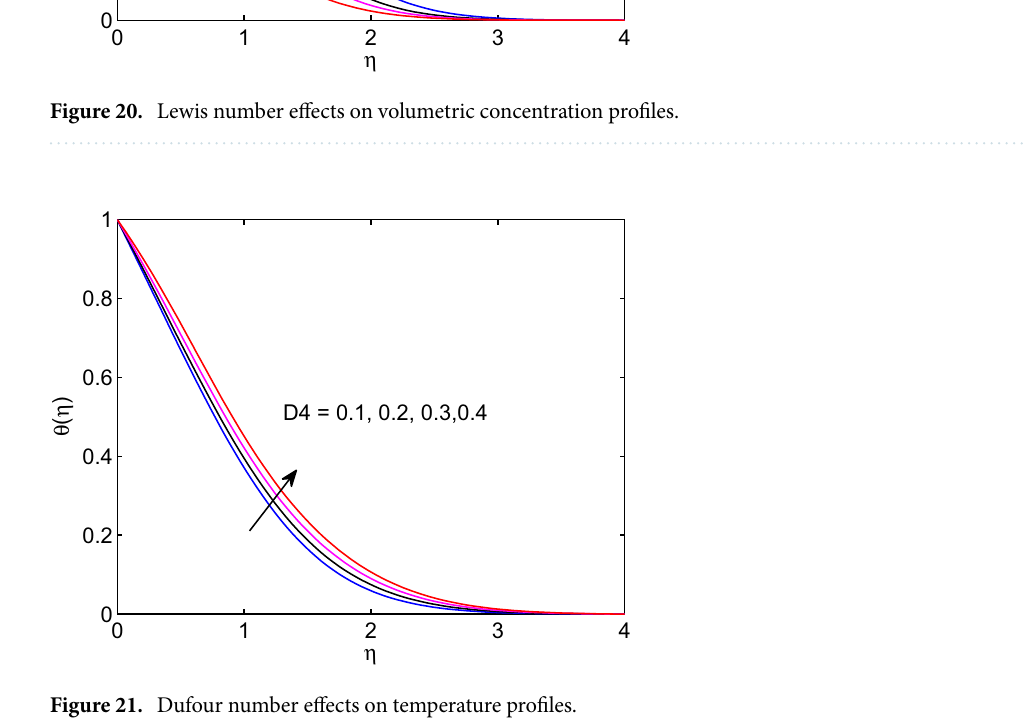
Figure 21. Dufour number effects on temperature profiles.